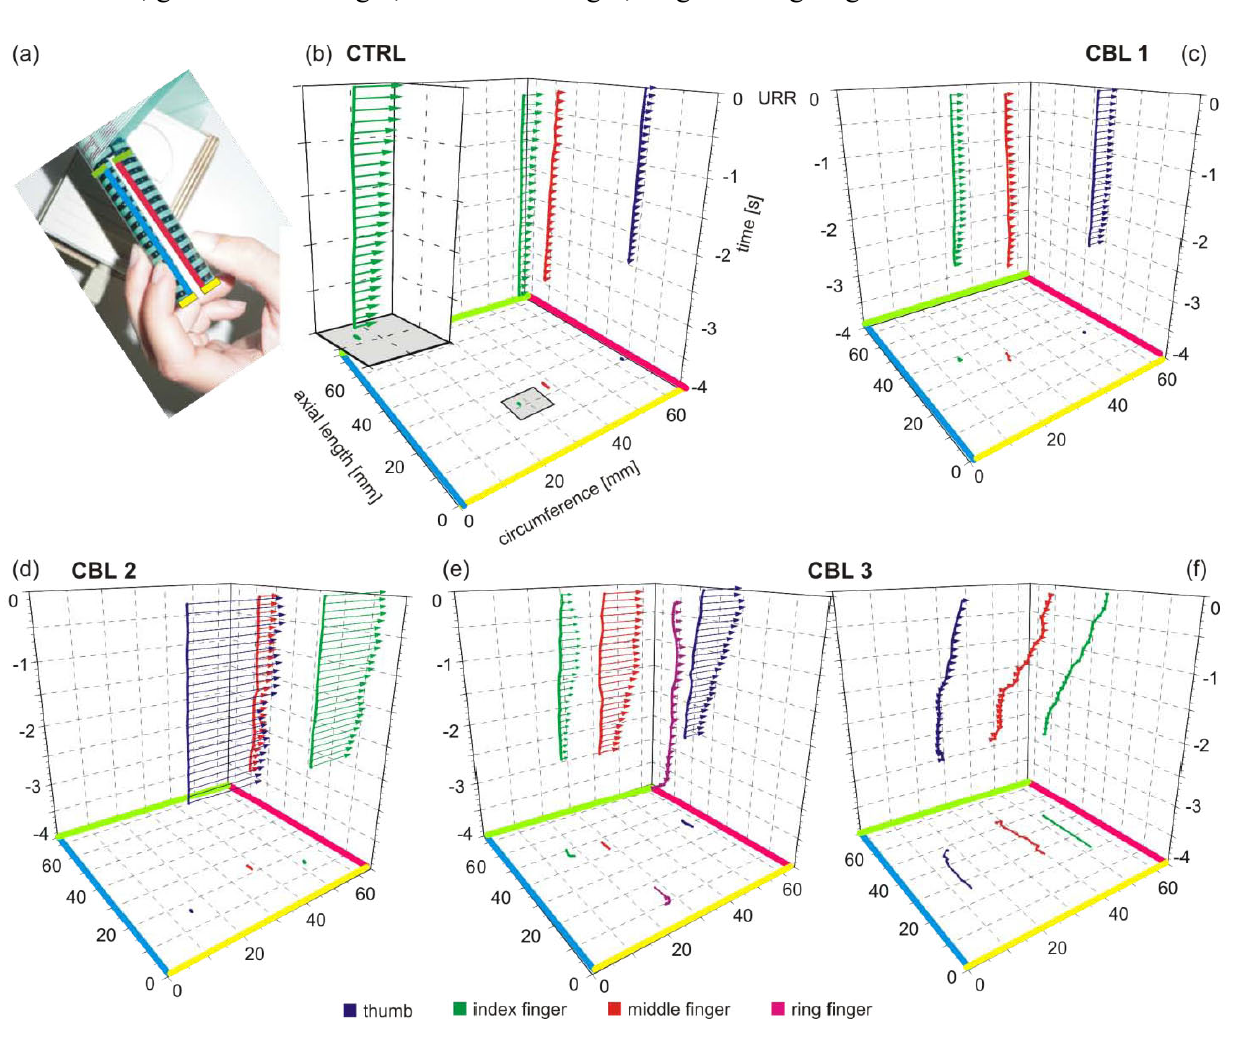
Figure 3. Spatio-temporal grip profiles of a healthy subject and three patients with degenerative cerebellar disease. Each plot shows the data of a single trial from 3.5 s before rod release up to URR at t = 0. (a) Demonstration of the requested three-finger grip. (b-f) Space-time cube of grip forces with 3D-graph of finger position and grip force vectors at discrete time intervals (see text). (b) Grip forces of a healthy subject (CTRL), with the inset showing spatio-temporal grip profile of the index finger only. (c) Grip forces of a cerebellar patient (CBL1) with moderate hypermetric grip forces. (d) Grip forces of a cerebellar patient (CBL2) with strong hypermetric grip forces. (e) Grip forces of a cerebellar patient (CBL3) with hypermetric grip forces and the use of a four-finger instead of a three-finger grip (left hand). (f) Grip force data of the same patient as in (e) with hypometric grip forces sliding with the fingers along the rod (right hand). For b-f: blue - thumb, green - index finger, red–middle finger, magenta–ring